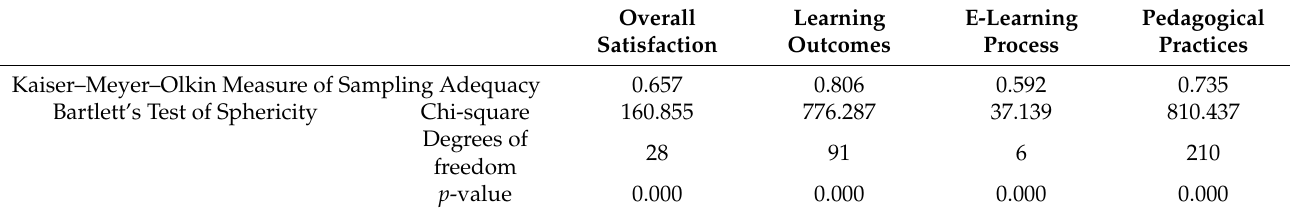
Table 17. KMO test and Bartlett’s test.